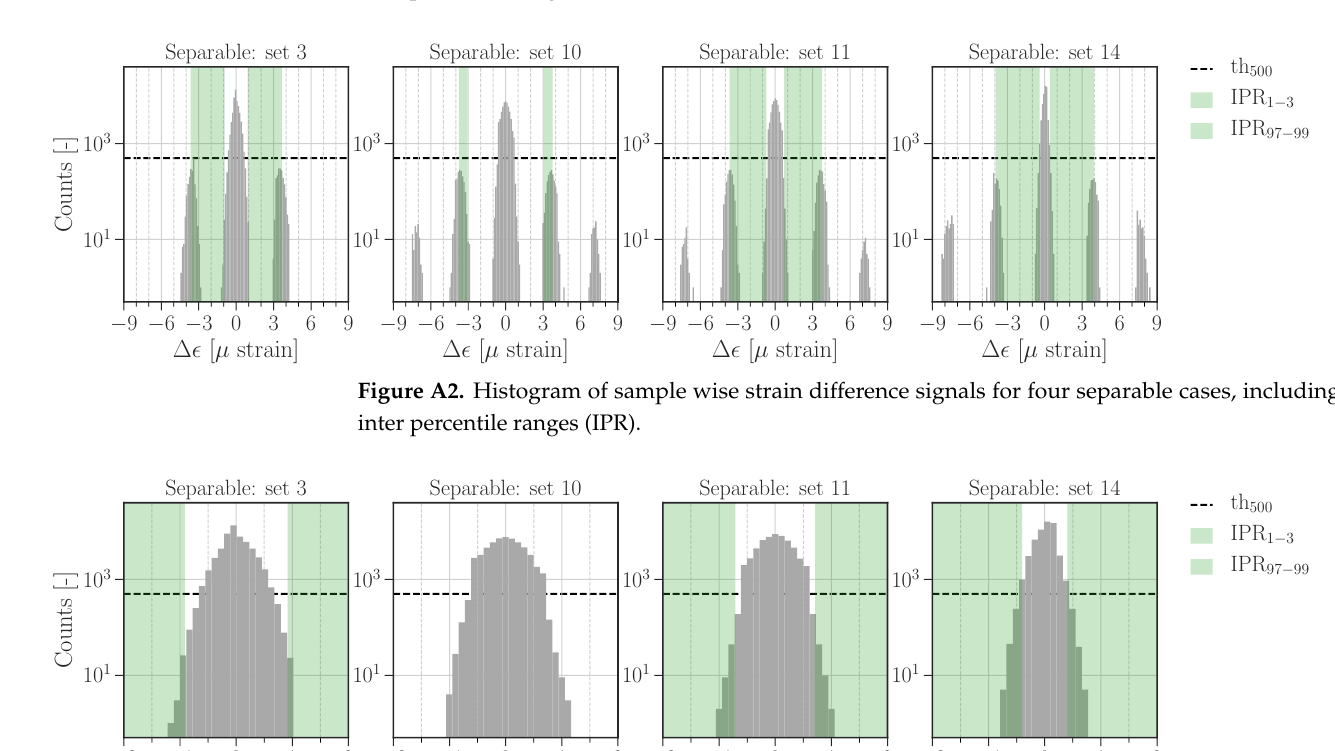
Figure A1. Histogram of sample wise strain difference signals for four overlapping cases, including inter percentile ranges (IPR).